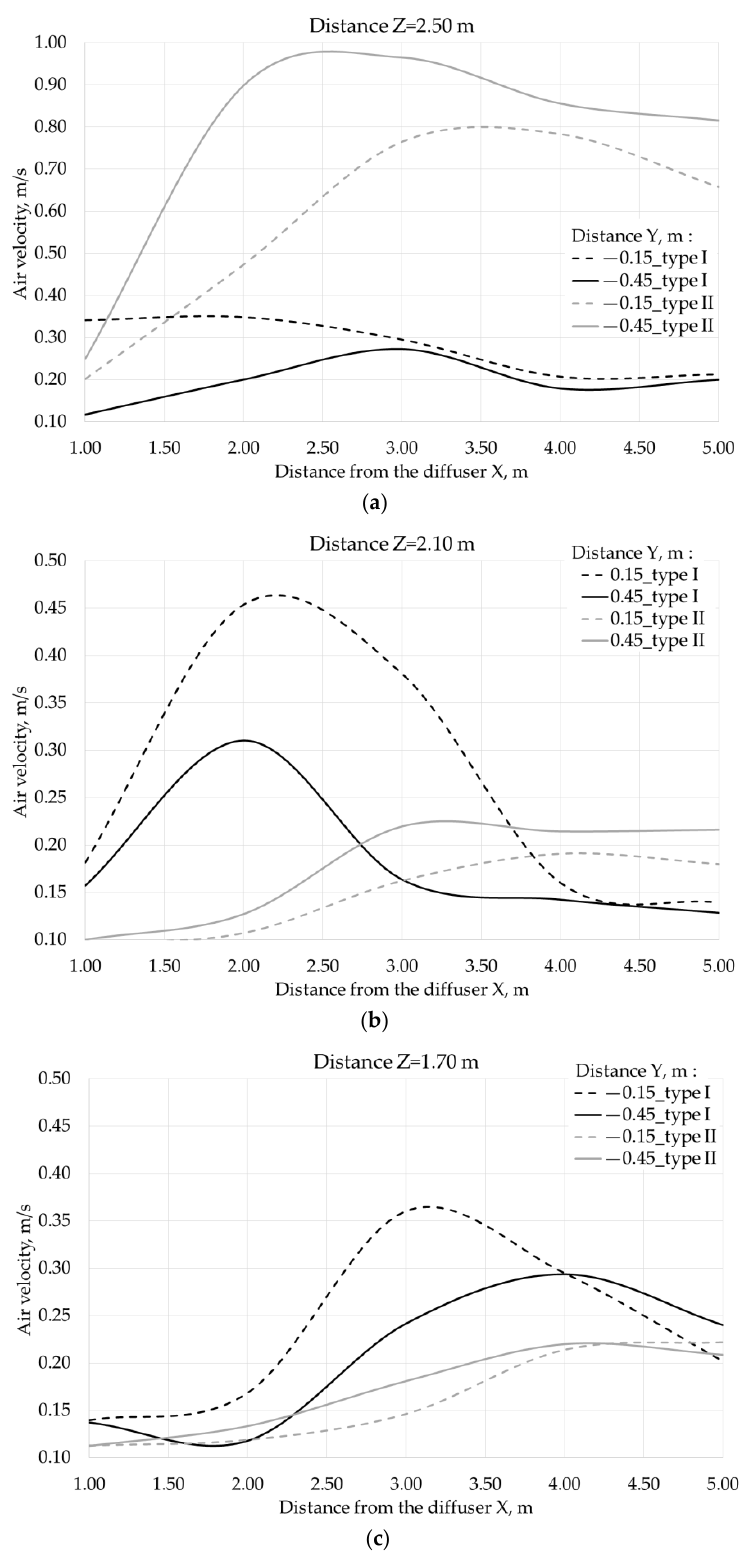
Figure 6. Results of air velocity measurements as a function of the distance from the diffuser Type I and Type II for height from the floor: ( a ) Z = 2.50 m; ( b ) Z = 2.10 m; and ( c ) Z = 1.70 m. For the selected planes, the highest velocity values were recorded for diffuser Type II near the ceiling (Z = 2.50 m). For diffuser Type I, the higher velocity occurred at the height of Z = 2.10 m. At the height of Z = 1.70 m, i.e., in the occupied zone, the limit ve-